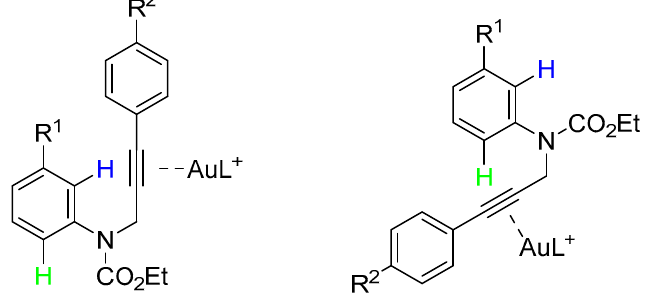
Figure 3. Ligand control of ortho / para site-selectivity.